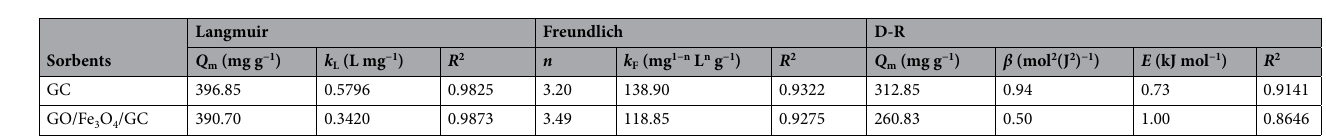
Table 1. Parameters of Langmuir, Freundlich and D-R model for U(VI) adsorption on GC and GO/Fe 3 O 4